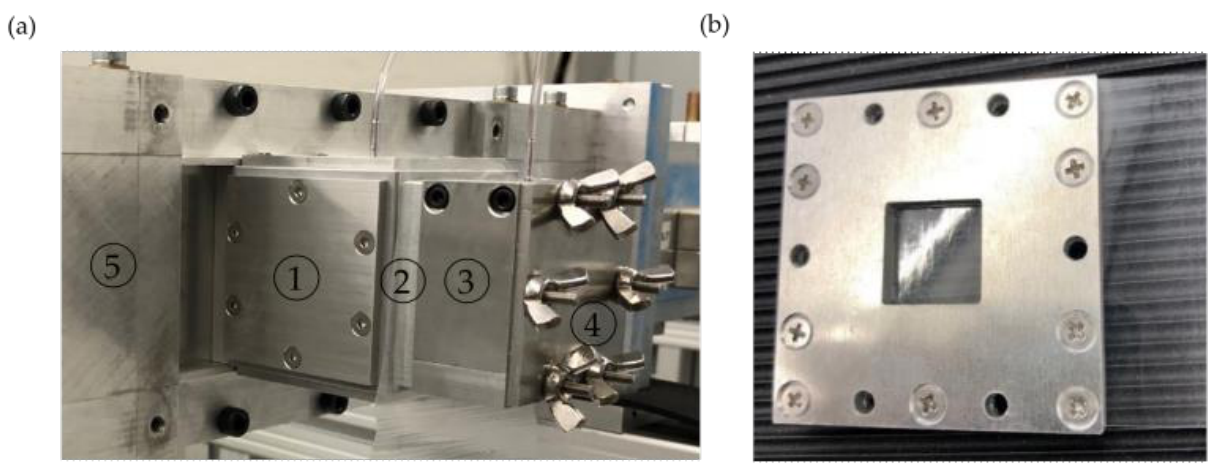
Figure 3. ( a ) 1 (cid:13) Assembly of resonator, 2 (cid:13) holder with film, 3 (cid:13) back cavity (here ~0.5 of resonator Figure 3. ( a ) ① Assembly of resonator, ② holder with film, ③ back cavity (here ~0.5 of resonator volume) and ④ back plate at the ⑤ DUCT-R; ( b ) holder with square cut-out and (TPU) film. volume) and 4 (cid:13) back plate at the 5 (cid:13) DUCT-R; ( b ) holder with square cut-out and (TPU) film.